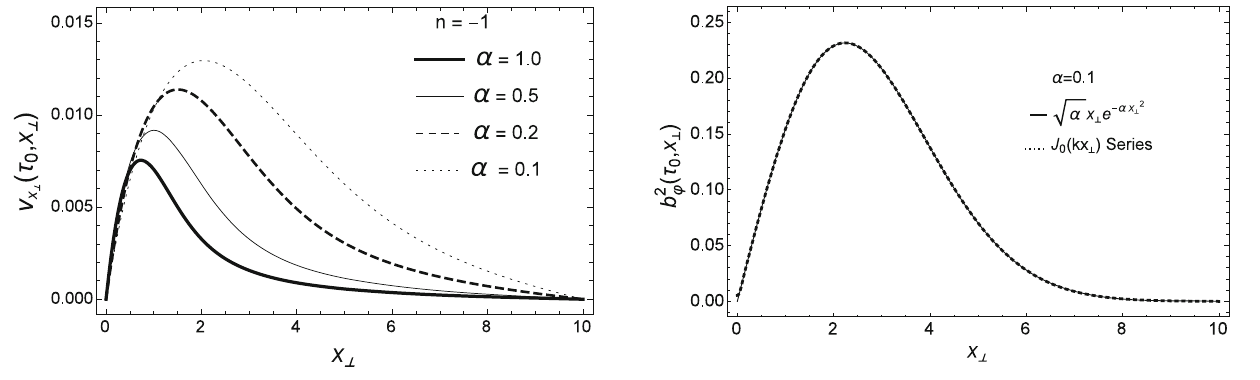
Fig. 10 v x ⊥ (τ, x ⊥ ) as a function of x ⊥ for different values of α at τ